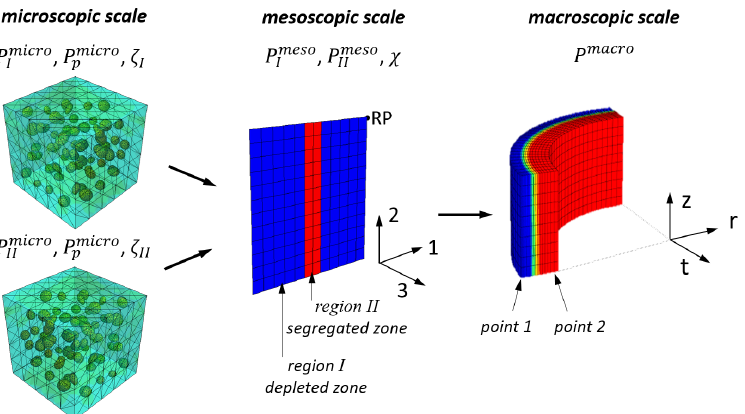
Figure 1. Schematic overview over the models and their properties P micro different length